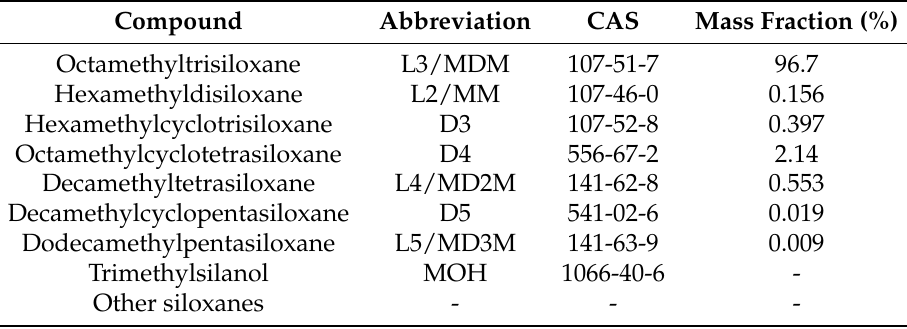
Table 10. HS-GC-MS analysis results of Experiment B, Product